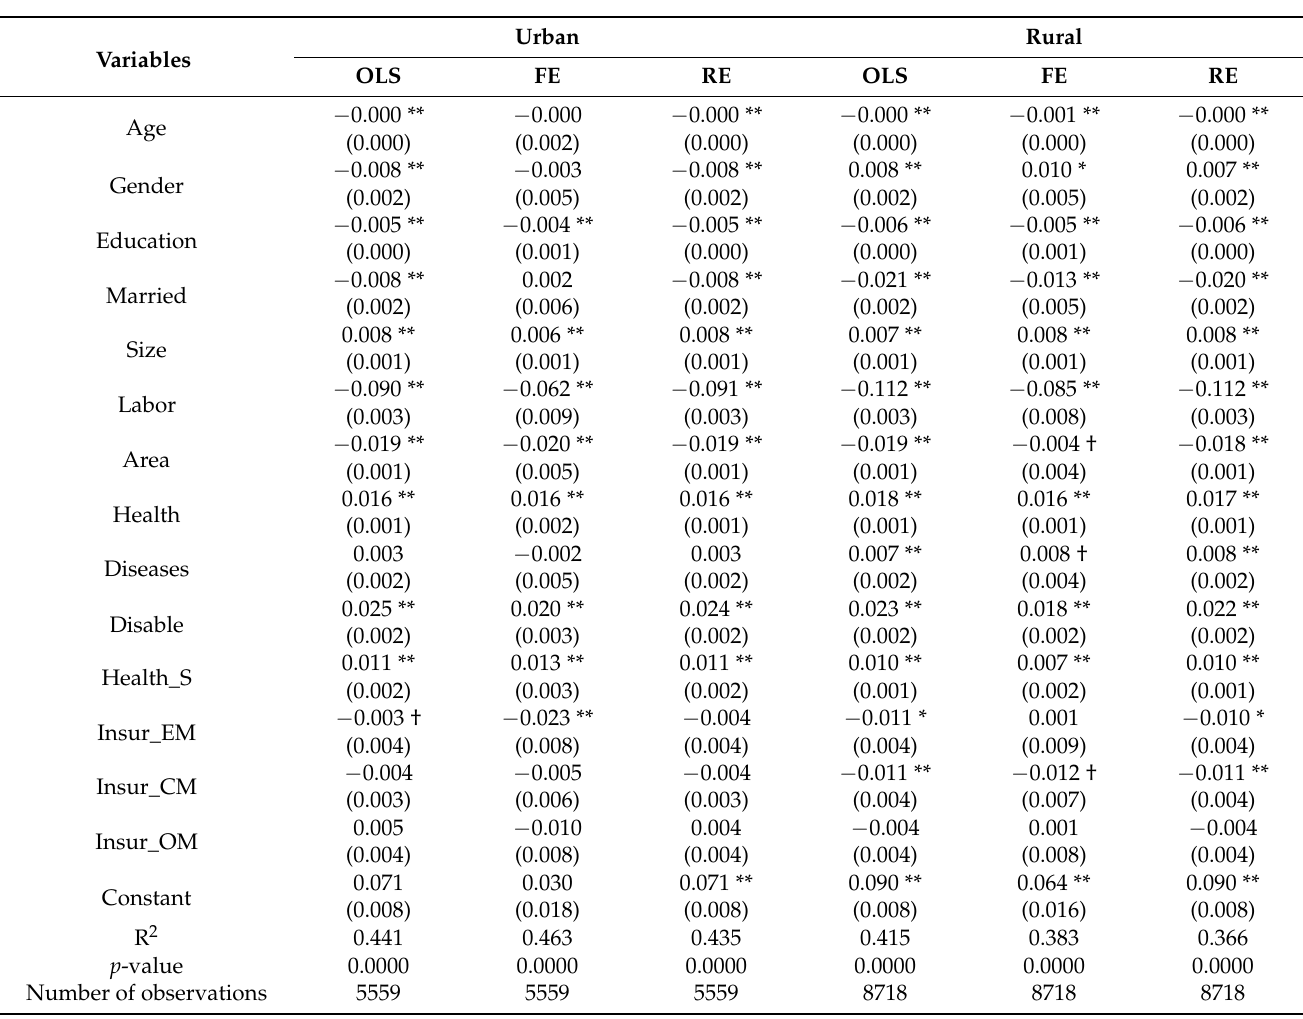
Table 6. Determinants of financial